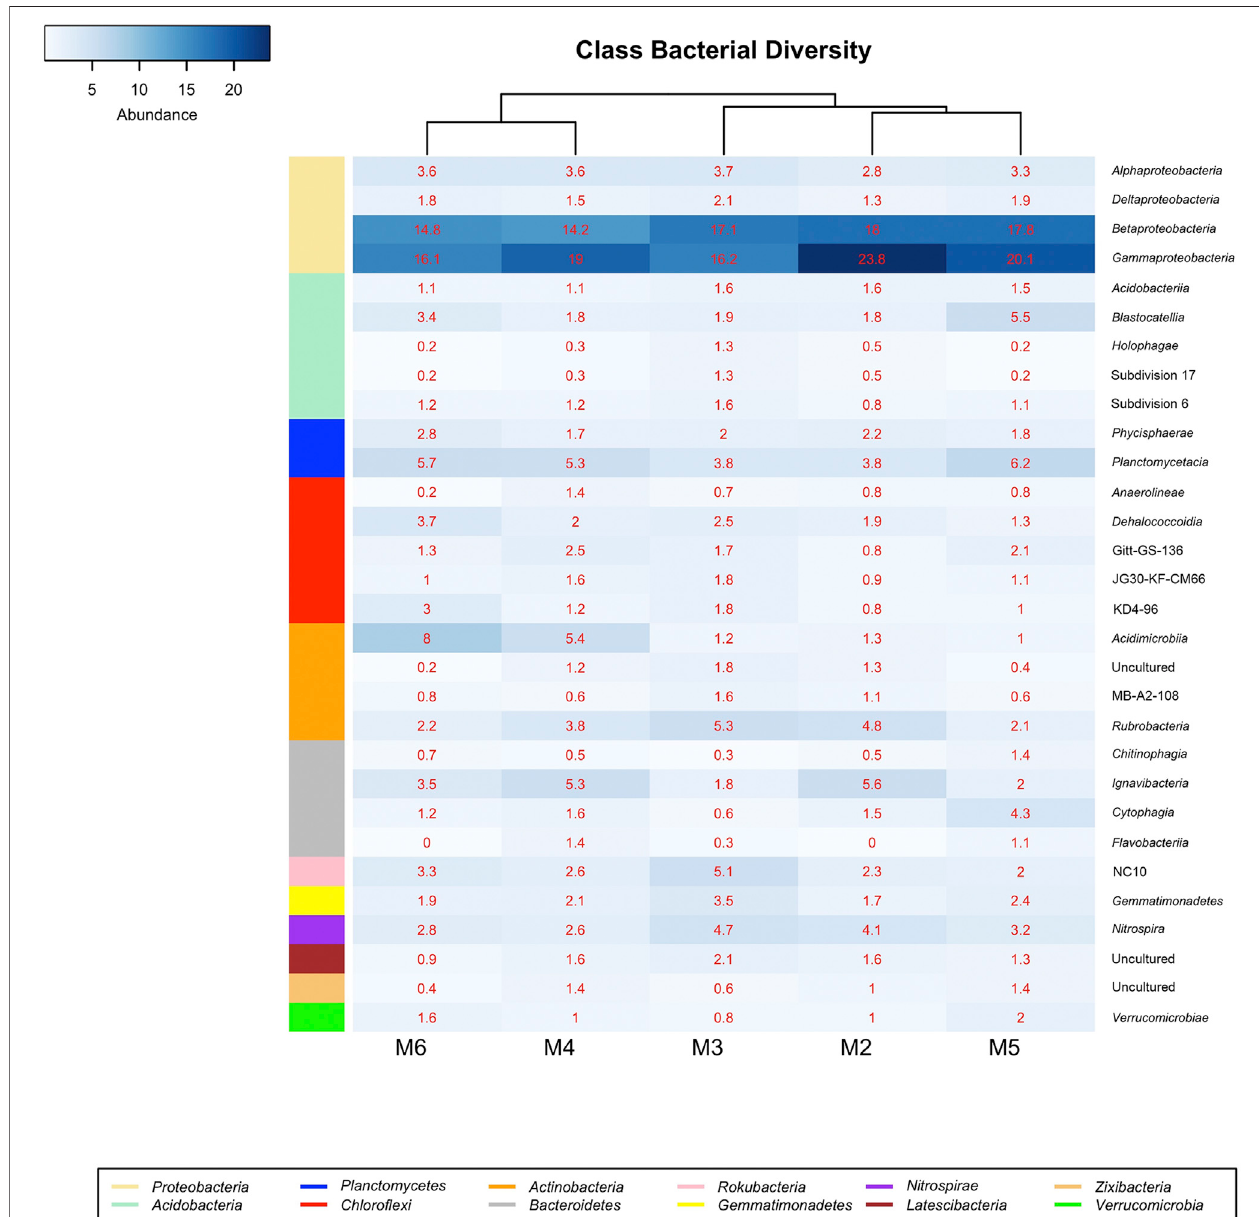
FIGURE6| Heat-mapanalysisofMorganaCavebacterialcommunityrelativeabundanceatclasslevel.Theidenti fi edgroupsarepresentedintherightcolumnand their phylum level indicated in left-colors column.